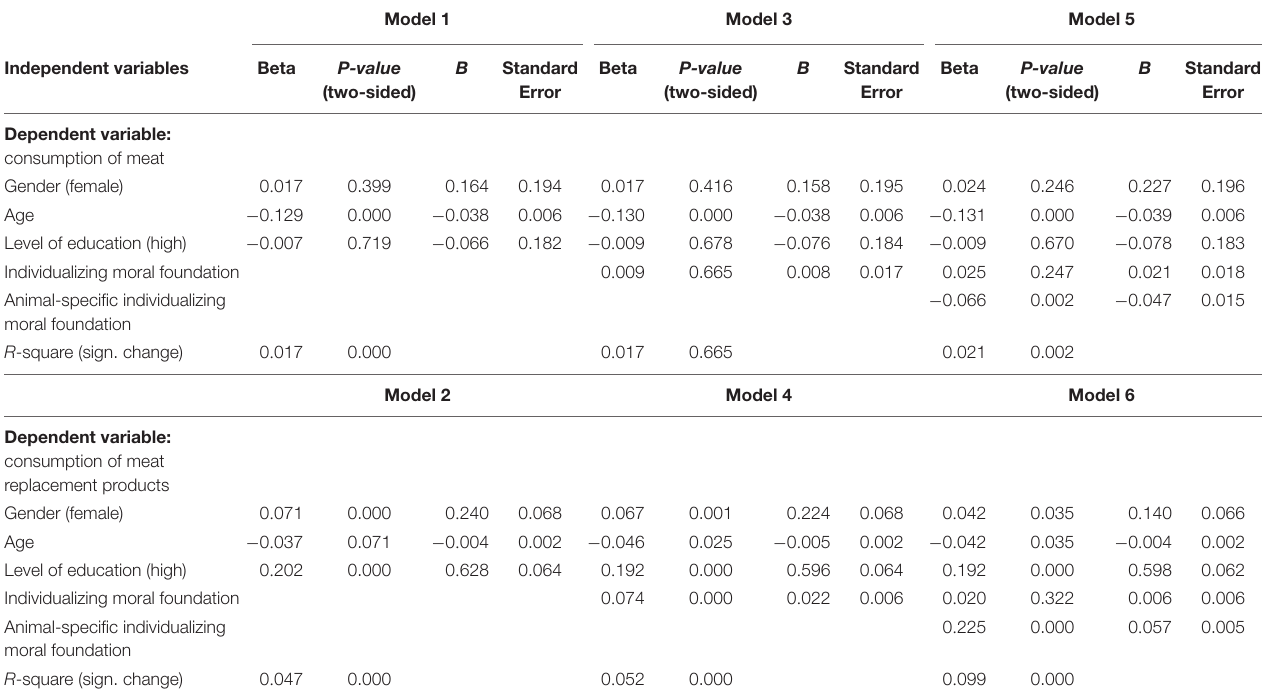
TABLE 11 | Coefficients of regression models predicting consumption of meat and meat replacement products (Study